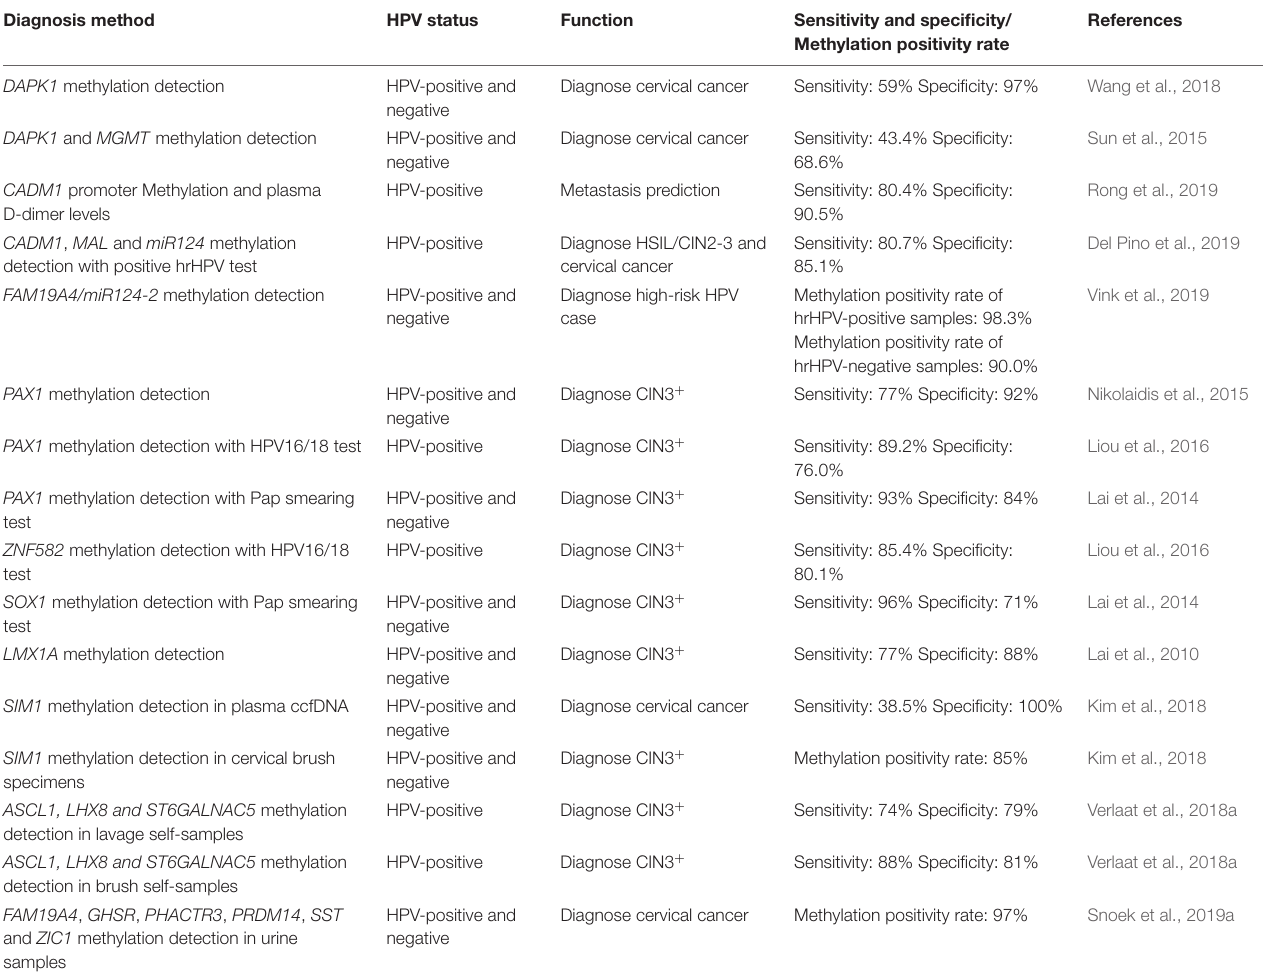
TABLE 2 | Sensitivity and specificity or Methylation positivity rate of methylation diagnosis